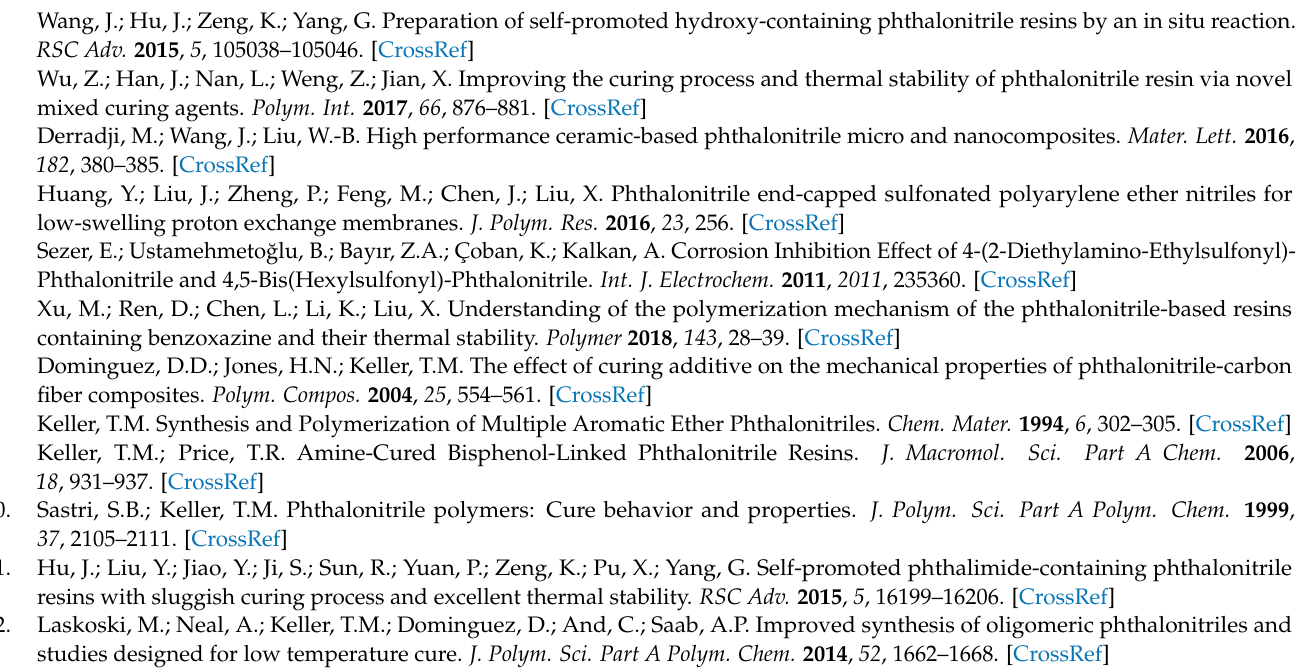
mers after curing; Figure S3: Rheological curve of BPh monomer; Figure S4: FTIR spectrum of BPh-B prepolymer; Figure S5: TGA curves of (a) BPh-B; (b) BPh-Q 5 ; (c) BPh-Q 10 ; (d) BPh-Q 15 ; (e) BPh-Q 20